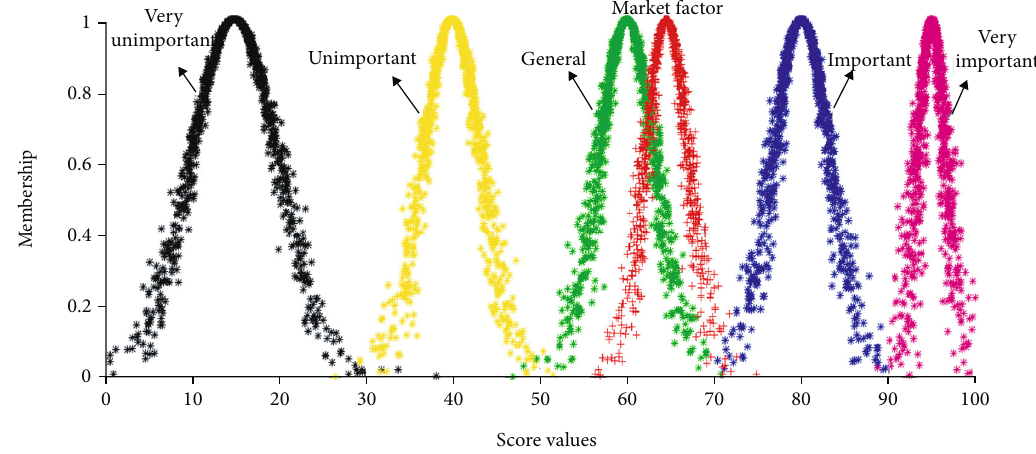
Figure 8: The comprehensive evaluation of market factor.